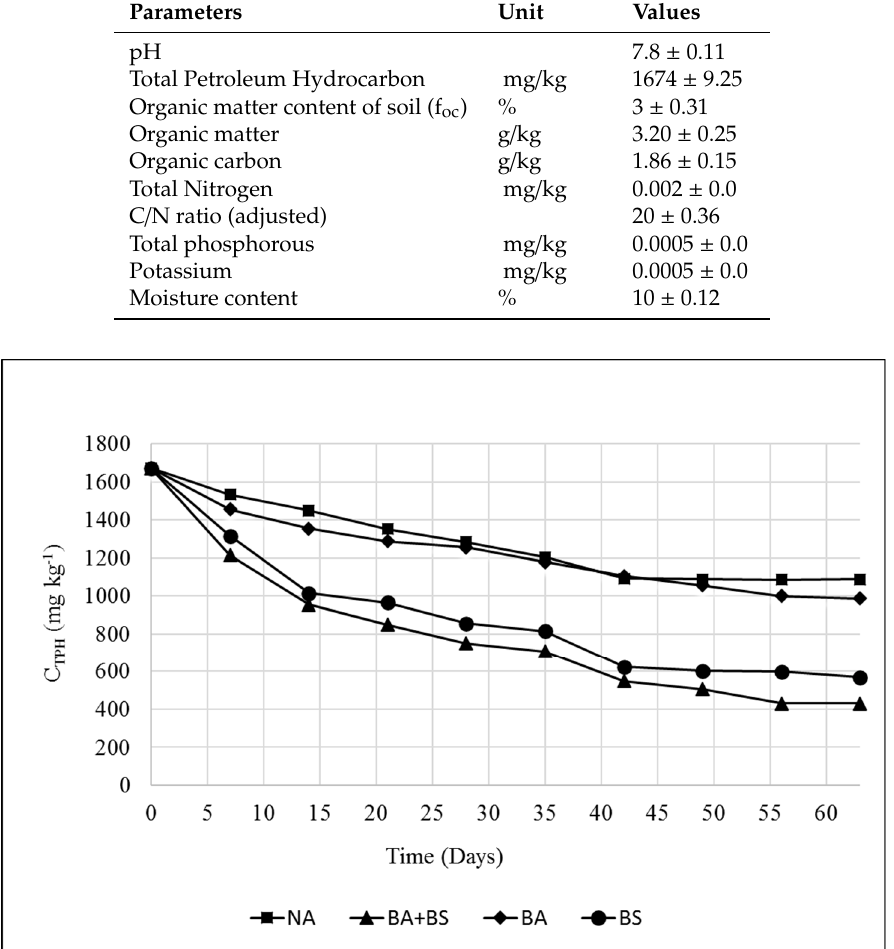
Figure 2. Changes in Total petroleum hydrocarbon (TPH ) concentrations in the treatment tanks.